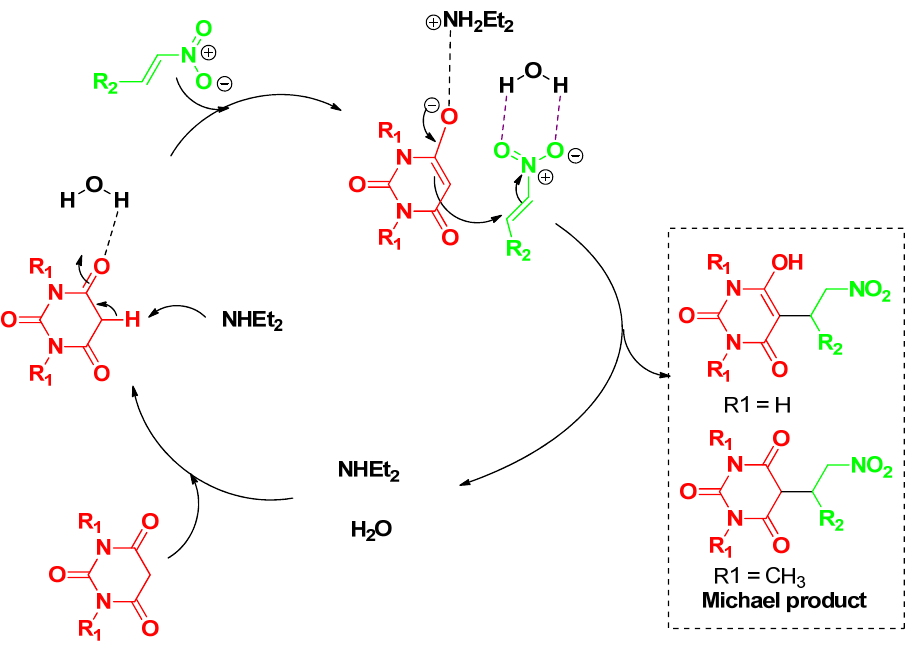
Entry Condition Time Yield (%) b 1 Et 2 iPr 3 (Cyclohexyl) 4 Morpholine/H 5 NaOH/H 6 Et